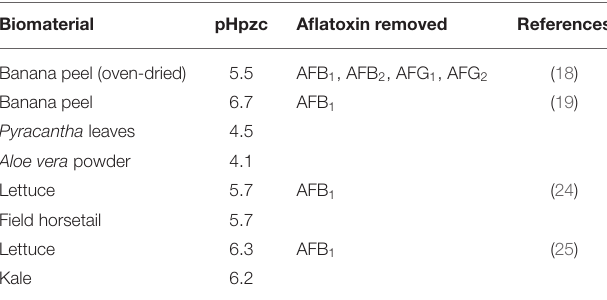
TABLE 5 | Point of zero charge (pHpzc) values of the agro-waste-based materials used for aflatoxins adsorption. Biomaterial pHpzc Aflatoxin